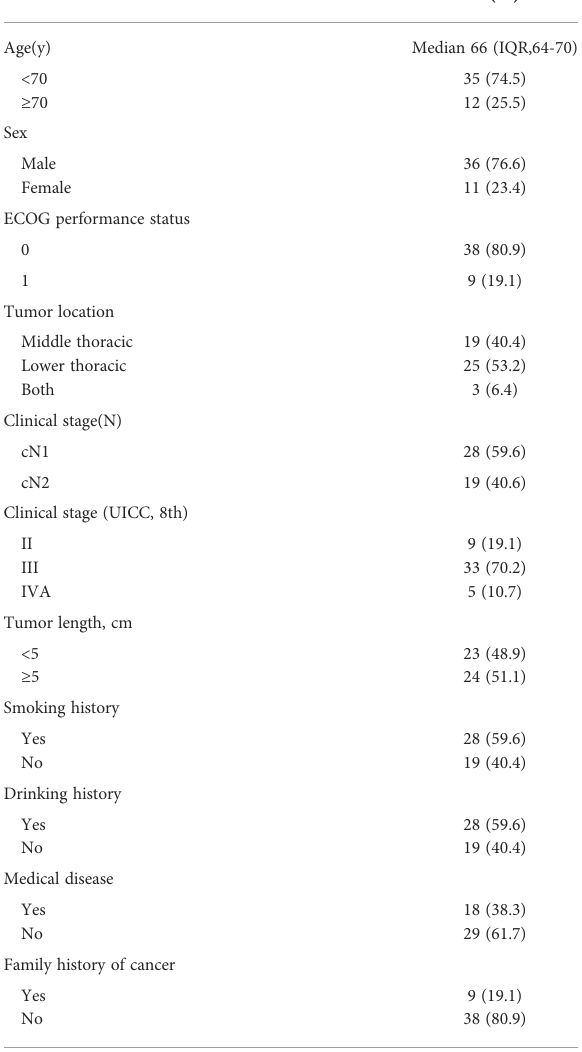
TABLE 1 Baseline characteristics of enrolled patients (N=47